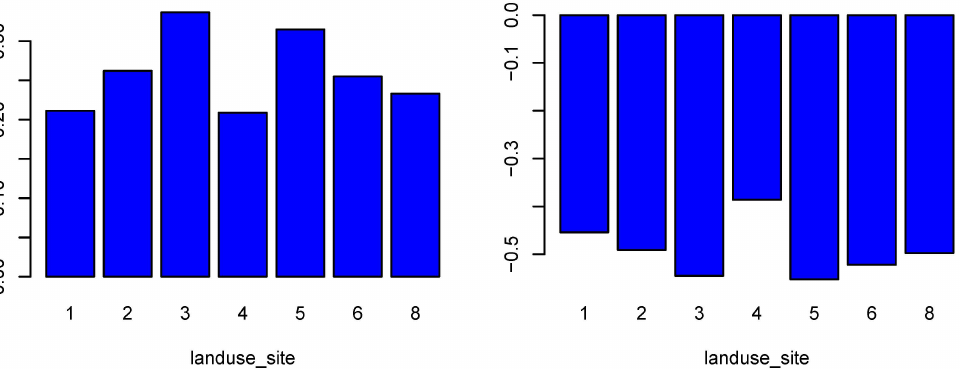
Figure A3. Partial dependence plot to understand the marginal effect of a single predictor on model prediction outcomes.